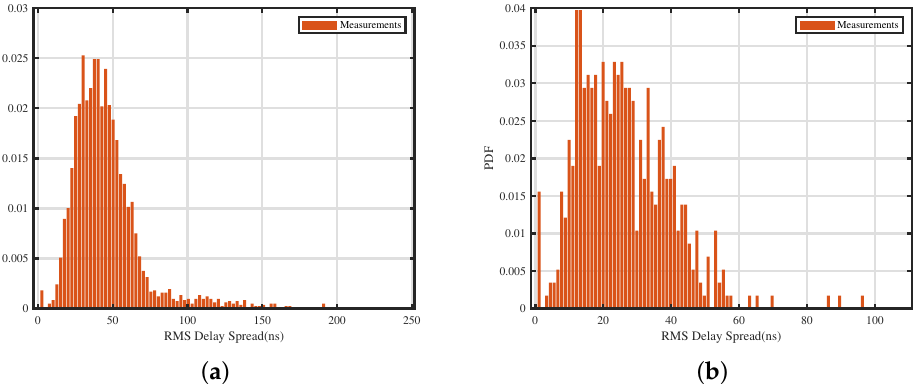
Figure 10. PDF of RMS delay spread values for Op1 and Op2 at measurement location 1. ( a ) Op1 ( b ) Op2.